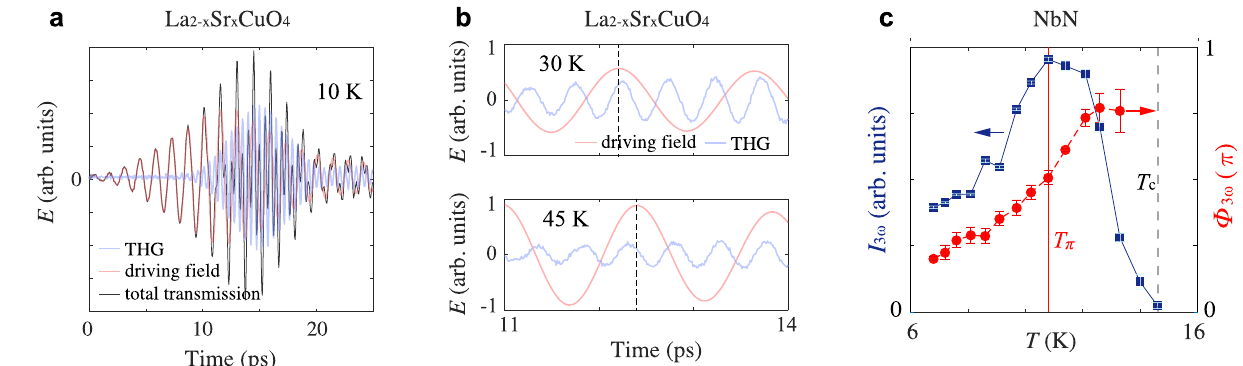
Fig. 2 | Third harmonic generation from terahertz-driven superconducting fl uctuations. a Terahertz transmission from an overdoped superconducting La 2 − x Sr x CuO 4 thin fi lm as it is pumped by a 0.7THz driving pulse. The latter drives the 2 ω amplitude oscillation of the superconducting order parameter (see Sup- plementary MaterialsS5for aclear experimentalvisualizationofthis 2 ω oscillation fromtransientre fl ectivitymeasurements).This2 ω collectiveexcitationscattersthe driving photon, leading to third harmonic generation (THG) in transmission. The driving fi eld (red) and the THG (blue) waveforms are extracted from the raw transmission data (black) using 1.4THz Fourier lowpass and highpass fi